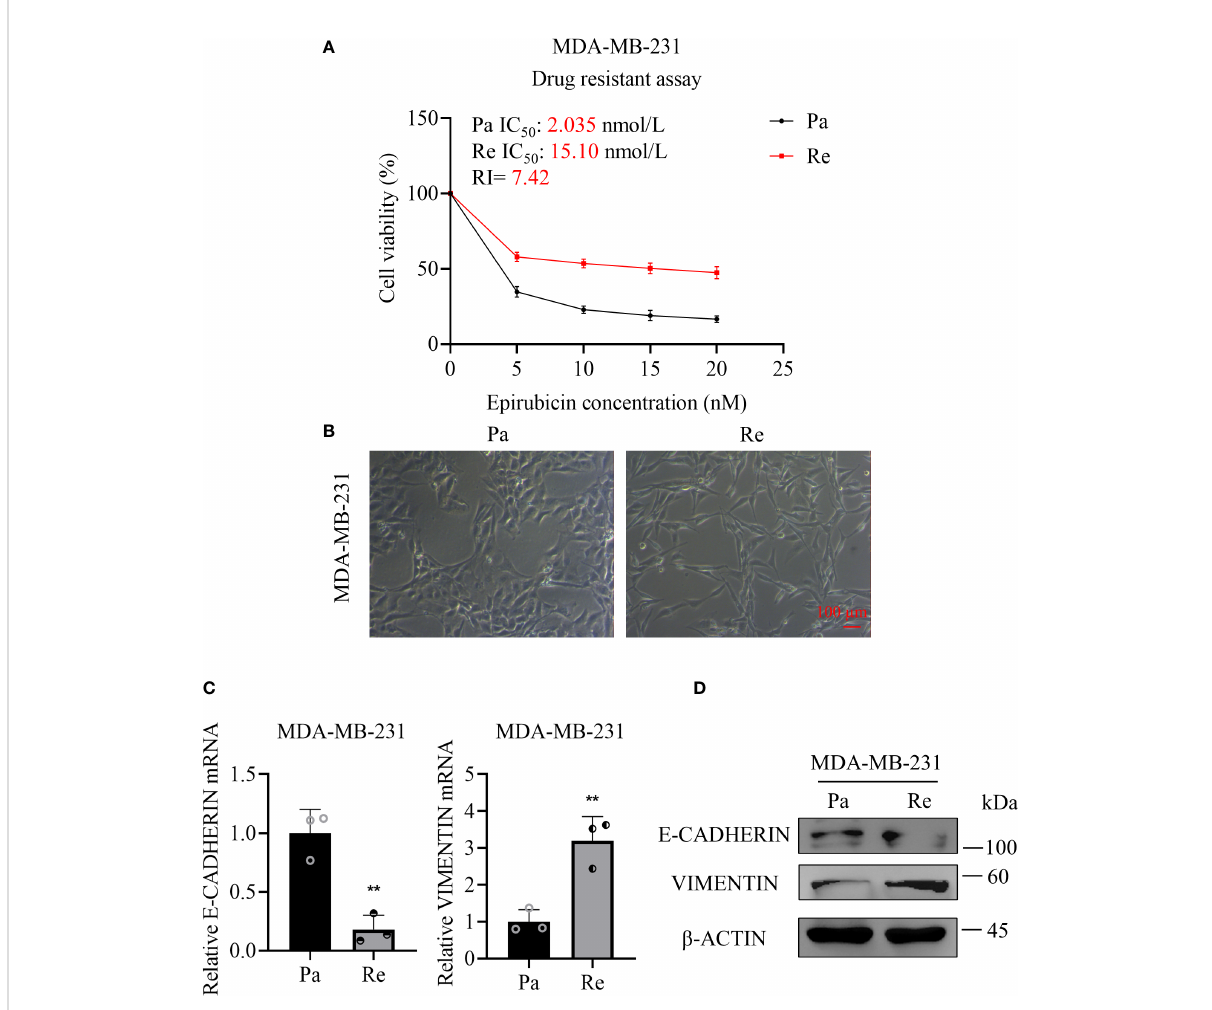
FIGURE 1 Drug resistance and cytomorphology of the drug-resistant triple negative breast cancer cell lines. (A) Cell viability detection after 24 h of Epirubicin treatment at various concentrations by CCK-8 assay. (B) Cell morphology was observed under a microscope. Scale bar =100 µm. (C) qRT-PCR assay for analyzing the expression of E-CADHERIN and VIMENTIN in MDA-MB-231-Re cells or MDA-MB-231-Pa cells. (D) Protein levels of E-CADHERIN, VIMENTIN and b -ACTIN were determined by western-blotting assay. All data were shown as mean ± SD (N=3 independent experiments). **P